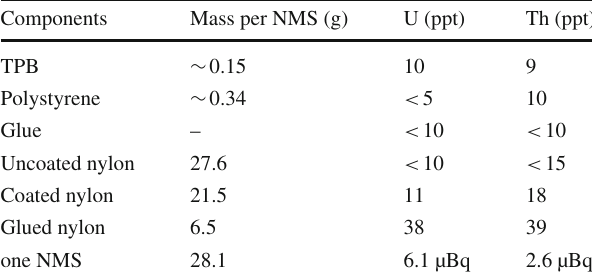
Table 1 Radiopurity of the components of the NMS from ICP-MS measurements. Uncertainties are estimated to be about 30%. The upper limit is 90% C.L